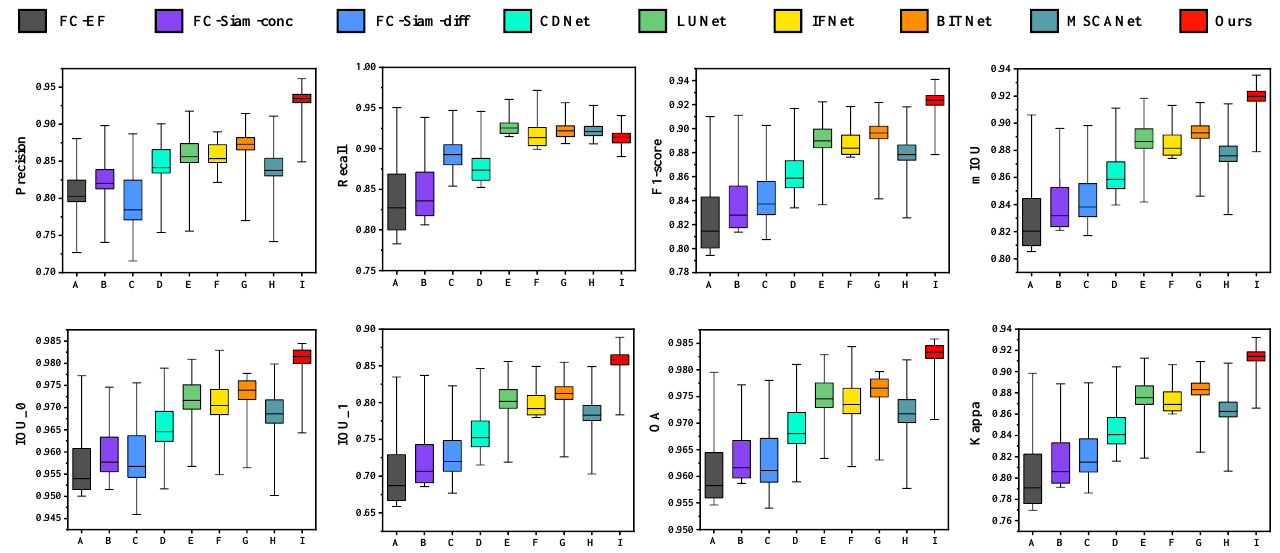
Figure 12. Eight metrics results of box diagrams for 921 images from the LEVIR-CD dataset. The nine alphabets A-I on the horizontal axis represent FC-EF, FC-Siam-conc, FC-Siam-diff, CDNet, LUNet, IFNet, BITNet, MSCANet, and our method, respectively.